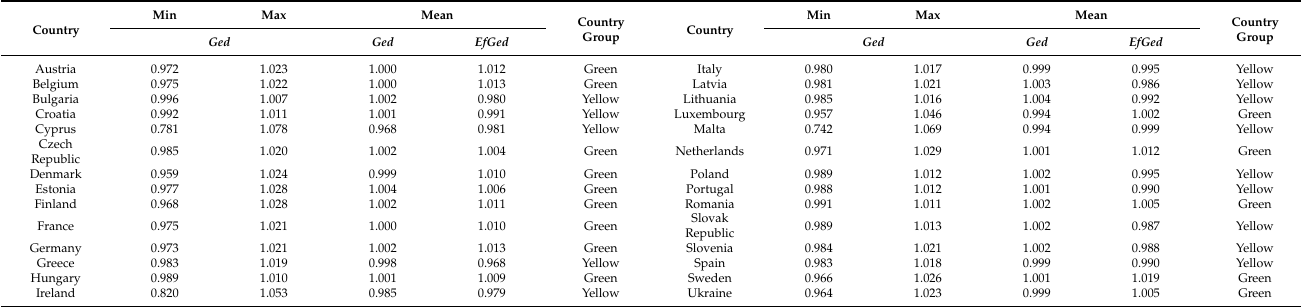
Table 4. The empirical results of green economic growth and efficiency of the government reforms and programmes on achieving sustainable development goals among countries analysed in the period of 2005–2020.